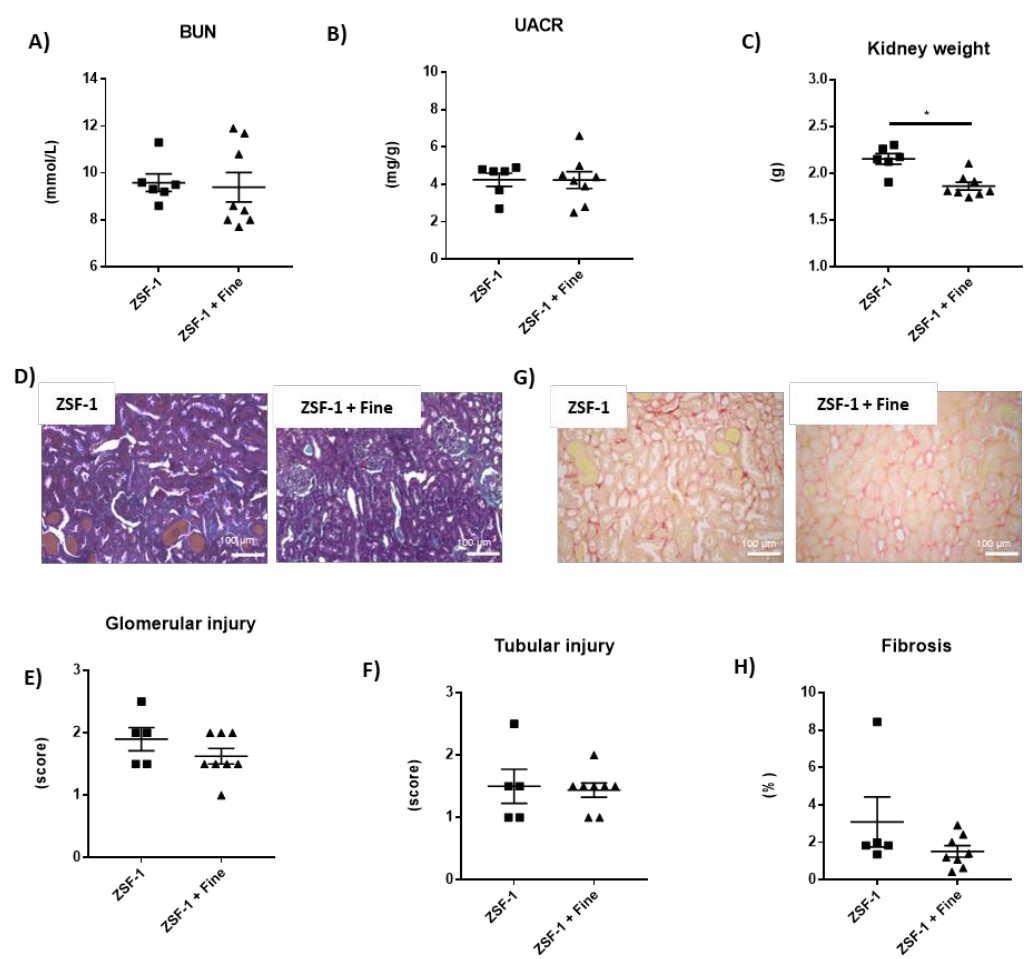
Figure 3. Kidney hypertrophy is reduced by finerenone treatment after 12 weeks. Blood urea nitrogen levels ( A ), urine albumin to creatinine ratio ( B ), and kidney weight ( C ). Representative light microphotographs (20 × magnification) of rat kidney sections stained with Masson Trichrome ( D ) and Sirius red ( G ); glomerular ( E ) and tubular injury quantification ( F ), kidney fibrosis ( H ). Student’s t -test was used for statical analysis, n = 5–8. * p < 0.05 vs. ZSF-1. Finerenone treatment did not alter LV end-diastolic diameter (Figure 4A) and LV end-systolic diameter (Figure 4B) but increased fractional shortening (Figure 4C), whilst stroke volume (Figure 4D) and cardiac output (data not shown) were not modified. Systolic blood pressure was not modified by finerenone (mmHg, 204.6 ± 3.1 vs. 195.4 ±